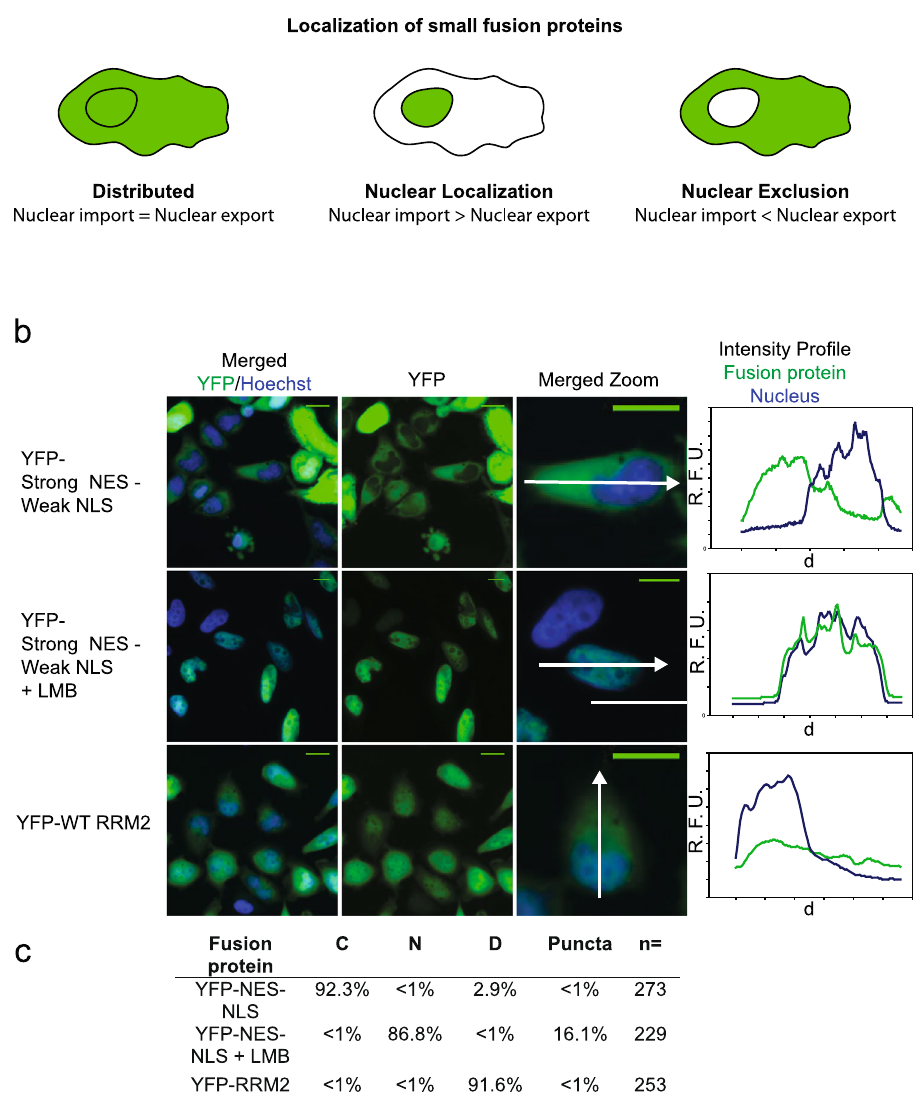
Figure 2. RRM2 is not sufficient for nuclear export. ( a ) Schematic of predicted localization of small fusion proteins. ( b ) Direct fluorescence of HeLa cells expressing the indicated fusion protein and treated with nuclear stain Hoechst. Merged image (Hoechst and YFP), YFP, and a close-up of Merged are shown. Scale bars are 10 um. Intensity plots for each image are shown; intensity was measured across the arrow in “Merged Zoom” panel. Intensity plots: y-axis is relative fluorescence, x-axis is distance. Indicated samples were treated with the XPO1 inhibitor Leptomycin B (LMB), 10 nM for 12 hours. ( c ) Cells from 3 independent experiments were categorized as nuclear “N”, “C” cytosolic, or “D” distributed. Apoptotic and mitotic cells were not categorized but were included in total cell count. Percentage of cells containing puncta is also indicated. n = number cells